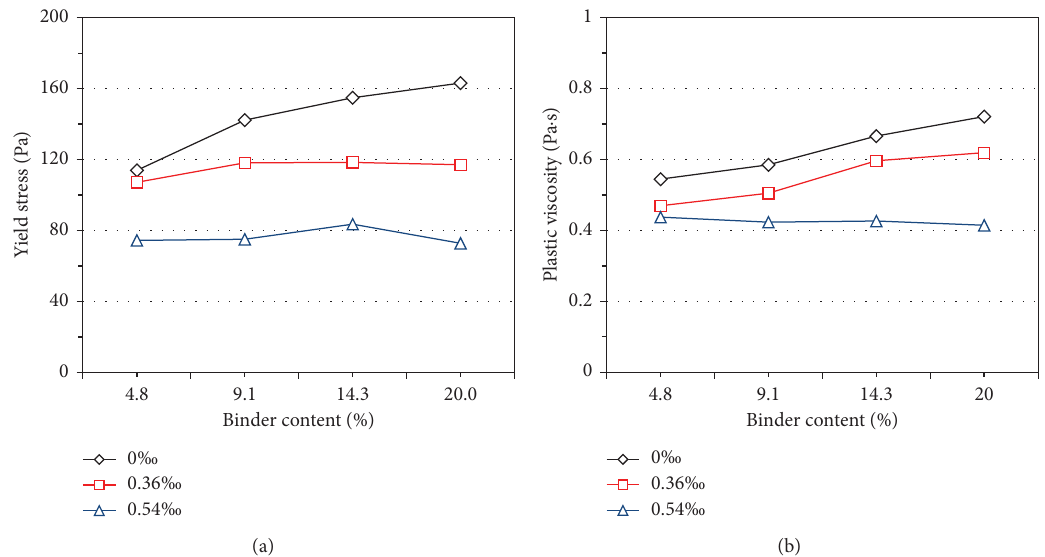
Figure 11: Effects of binder content and PC dosages on the development of (a) yield stress and (b) plastic viscosity of